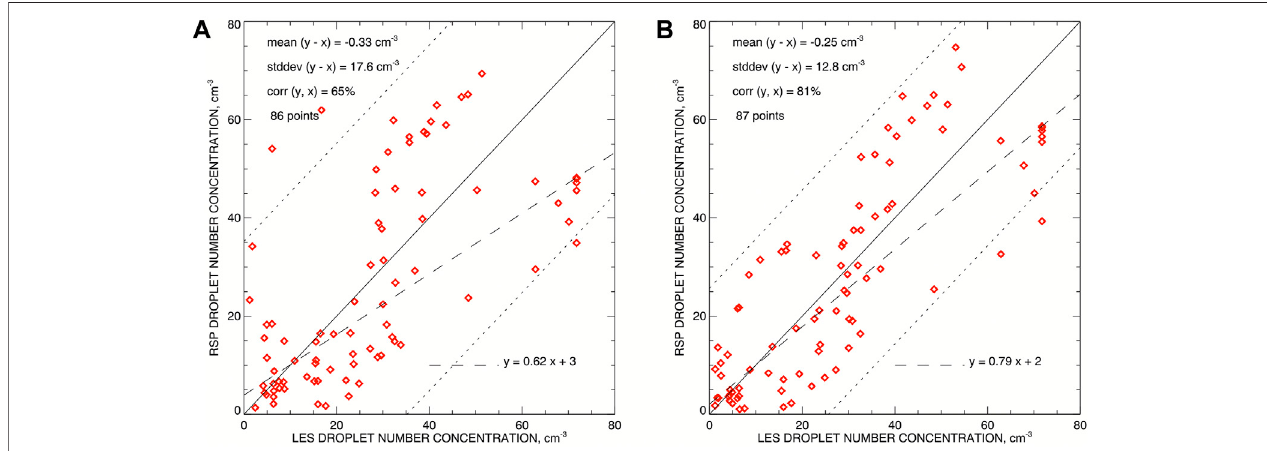
FIGURE 14 | Quantitative comparison between the retrieved droplet number concentration and the initial one from the LES model. The retrieved N c fi eld is interpolated to the LES data points. Only the data points with N c > 1 cm − 3 in both datasets are taken into comparison. (A) The original scatter plot of N c from both datasets. (B) Same as (A) but with the retrieved fi eld shifted to the right (away from the brighter cloud side) by 50 m (as in Figure 13B ).